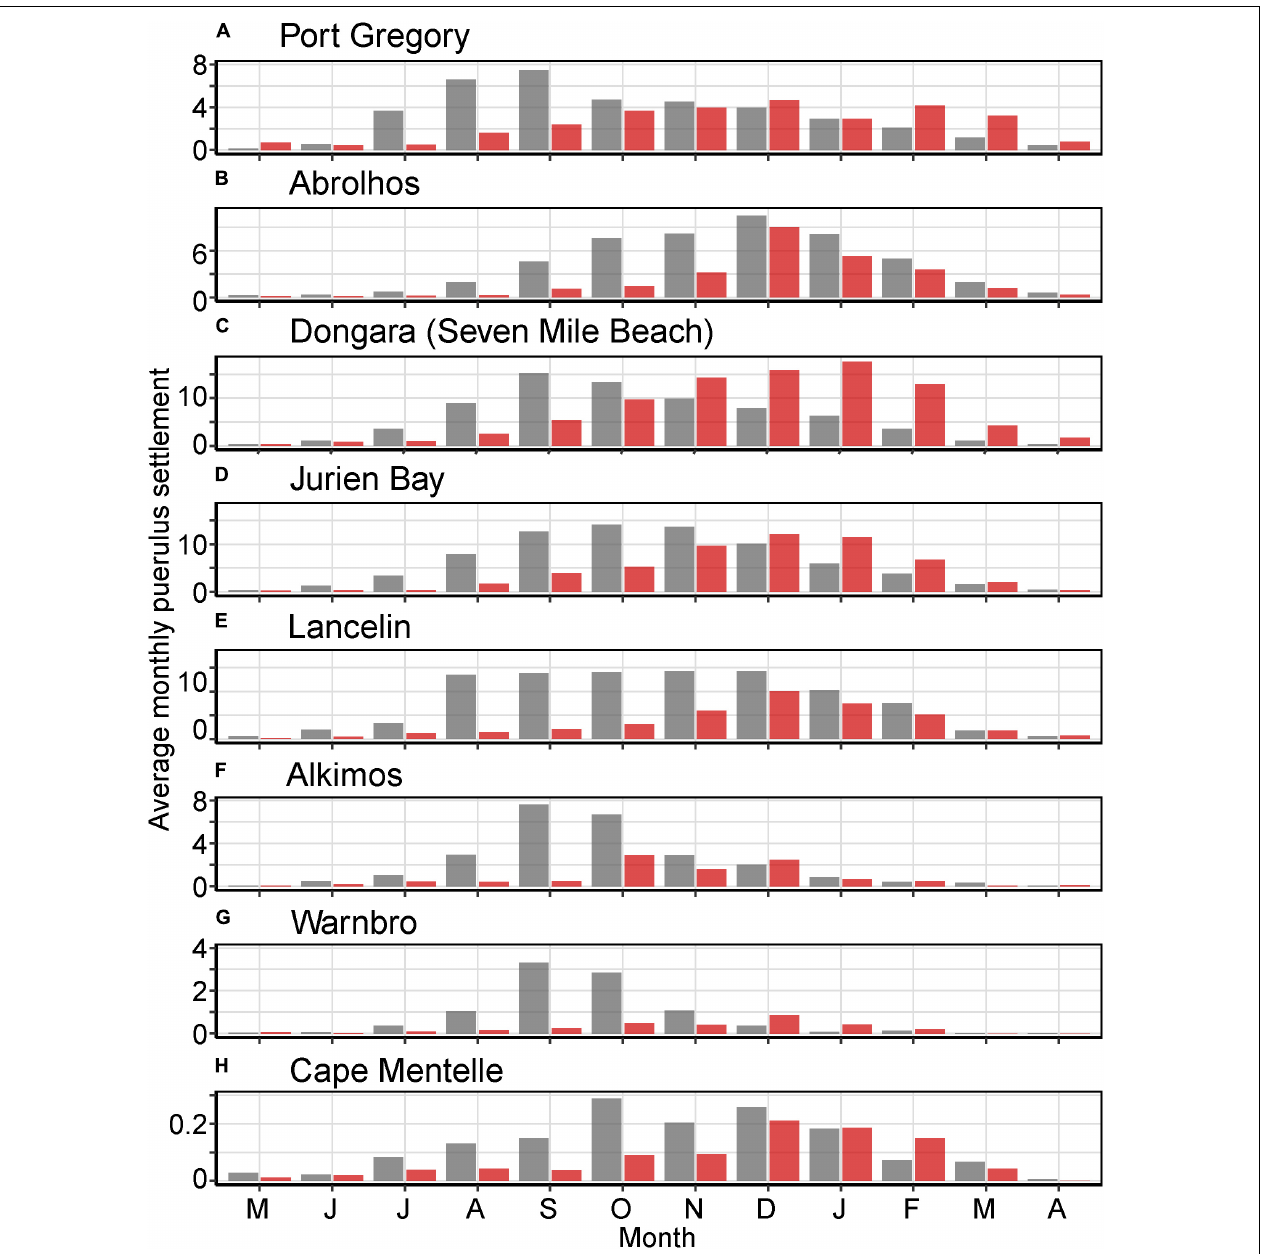
FIGURE 3 | Average monthly puerulus settlement over the season (May—April) at each survey site before (gray) and after (red) the 2007 downturn in the puerulus index, with 2007 to 2009 seasons removed. In order of latitude from north to south (A) Port Gregory (B) Abrolhos (C) Dongara (Seven Mile Beach) (D) Jurien Bay (E) Lancelin (F) Alkimos (G) Warnbro and (H) Cape